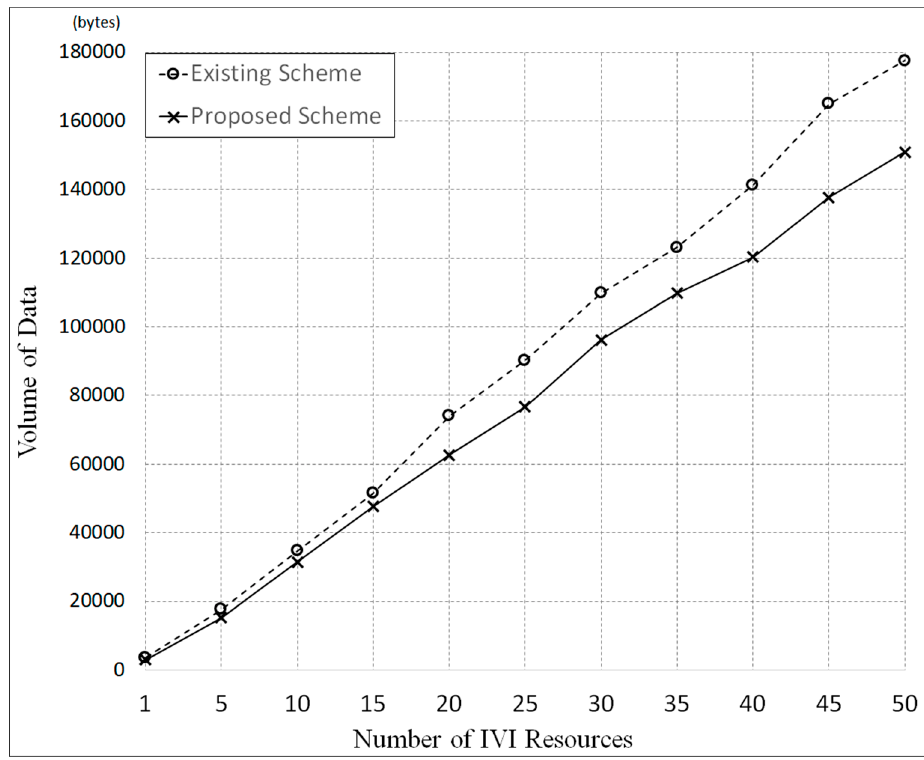
Figure 20. Comparison of data volume used for IVI resources control by experimentation.